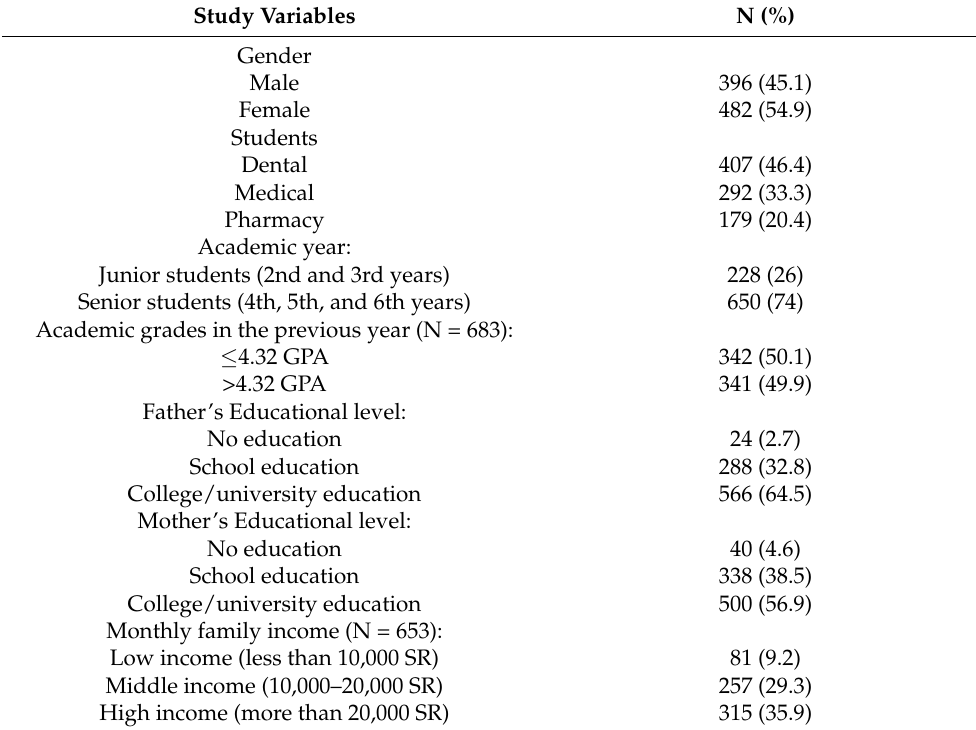
Table 1. Sociodemographic characteristics of medical and dental students (N =